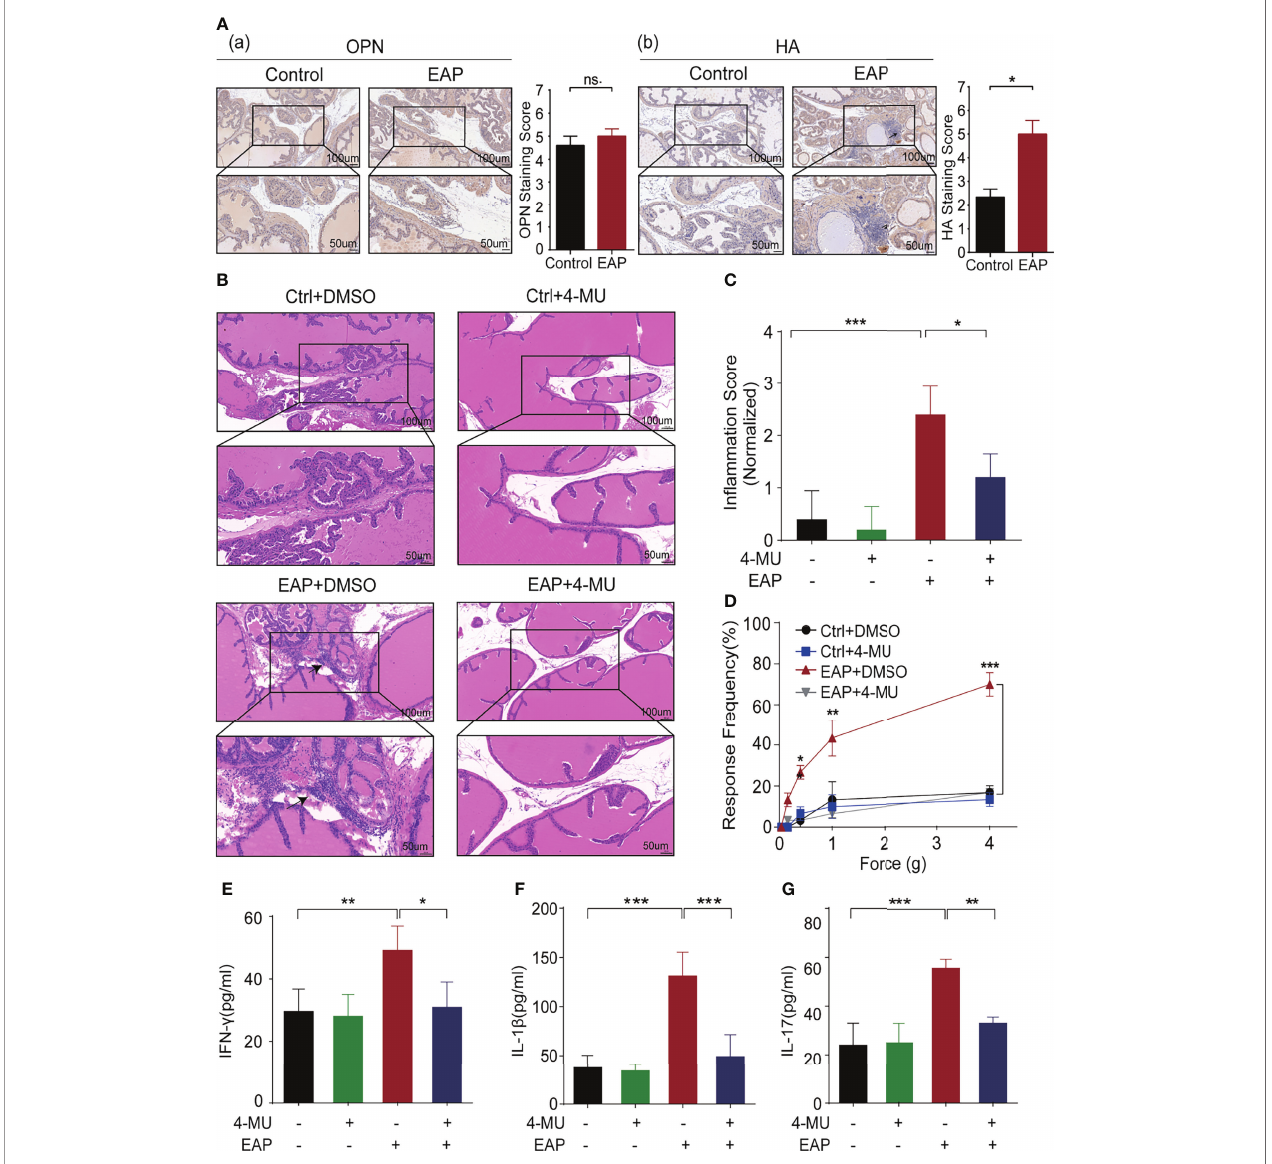
FIGURE 2 | Identi fi cation and validation of key ligand of CD44, HA, for CP/CPPS. (A) The expression of important ligands of CD44, OPN, and HA, in prostate tissues of mice between the control and EAP groups. (B) Analysis of histological difference by HE staining. (C) Corresponding histopathological score and data analysis according to data in Panel (B) . (D) Tactile allodynia development in NOD mice from those four groups. (E) The secretion levels of IFN- g in serum of NOD mice from those four groups. (F) The secretion levels of IL-1 b in serum of NOD mice from those four groups. (G) The secretion levels of IL-17 in serum of NOD mice from those four groups. ***p < 0.001, **p < 0.01, *p <